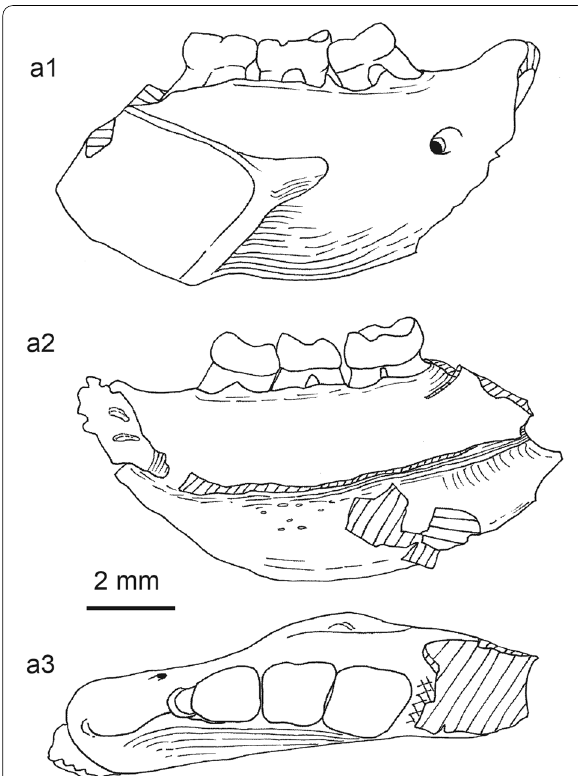
Fig. 17 Protadelomys lugdunensis Hartenberger, 1969, from Lissieu (Rhône), L44, right lower jaw; a1, labial side; a2, lingual side; a3, occlusal view. Scale bar 2 mm =